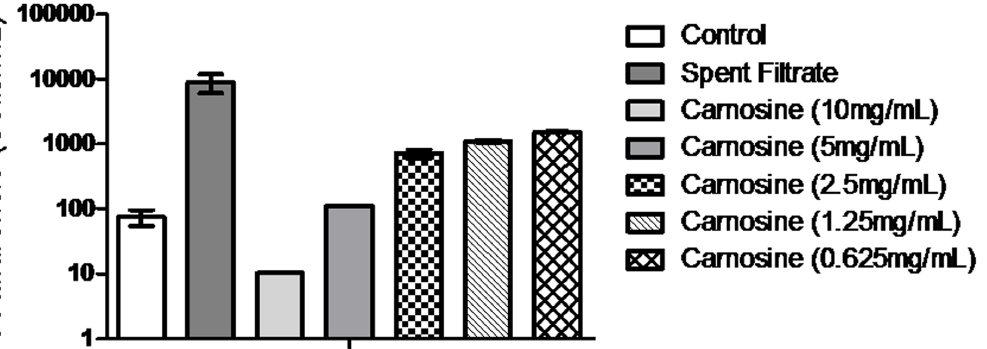
Fig. 5. Carnosine increases F. tularensis growth. F. tularensis (10 2 cells/mL) were incubated overnight at 37 ˚ C with agitation in control broth alone or supplemented with 10% spent culture filtrate or various concentrations of carnosine (0.625 mg/mL–10 mg/mL). DNA was extracted from all samples and analyzed by fopA real-time PCR. All samples were conducted in triplicate with technical triplicates. Legend: Control 5 white bar, Spent filtrate 5 dark grey bar, [carnosine 5 10 mg/mL (light grey bar), 5.0 mg/mL (medium grey bar), 2.5 mg/mL (checkered pattern bar), 1.25 mg/mL (diagonal pattern bar) and 0.625 mg/ mL (diamond pattern